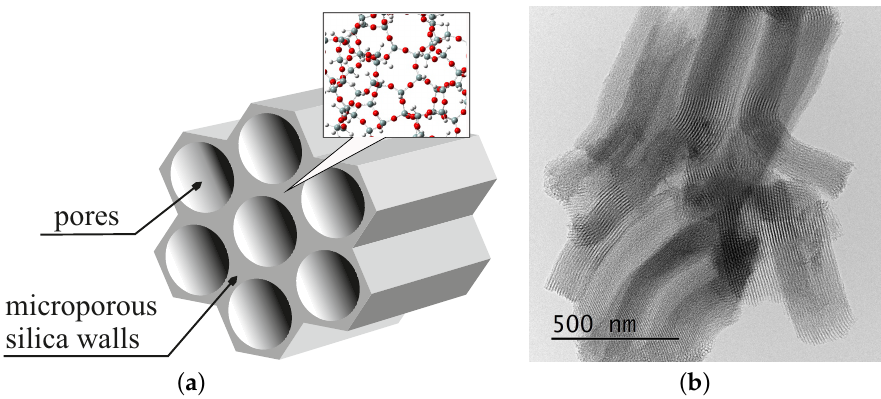
Figure 1. The structure of SBA-15 type mesoporous silica: a scheme ( a ); and a TEM micrograph ( b